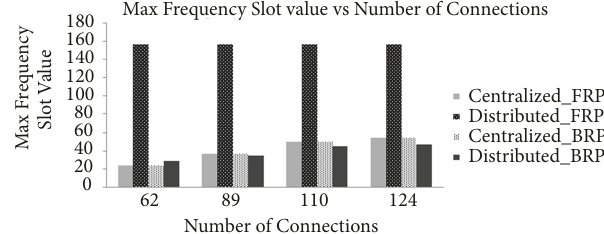
Figure24:MaximumfrequencyslotvalueforC-NOMandD-NOM using FRP and